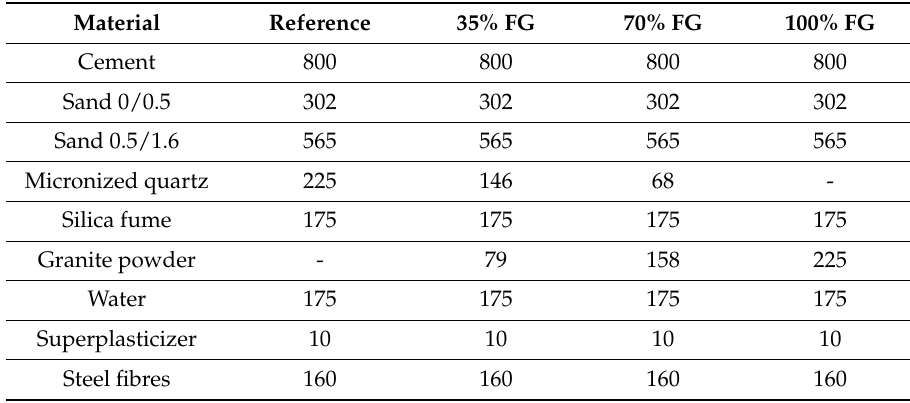
Table 4. UHPC composition (kg/m 3